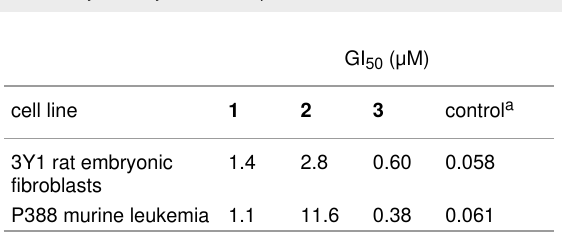
Table 3: Cytotoxicity data of compounds 1 – 3